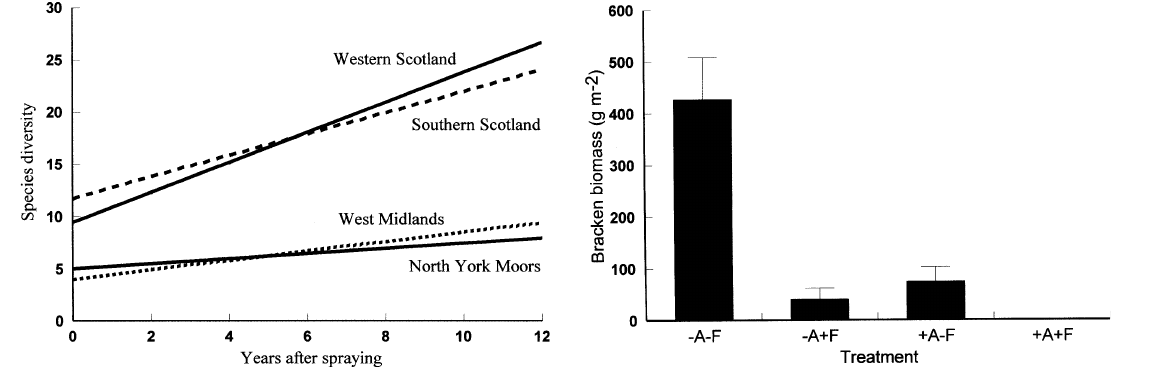
Fig. 2. The effects of herbicide spraying (asulam, +A) in 1993, , Hill 1973) in four 2 and follow-up spraying (+F) in 1996, on the mean biomass ( ± 1 SE, n = 27) of bracken in 1998 at Yr Orsedd,